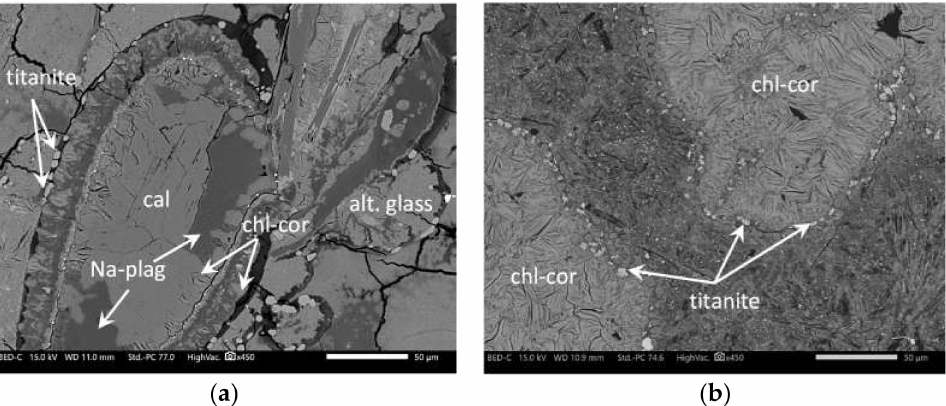
Figure 8. SEM petrographic observations in back-scattered electron mode. Chlorite (Chl), corrensite (Cor) ± Chl/Cor crystallizing inside vugs (filled by later calcite (cal) and Na plagioclase (Na-plag) ( a )). Alteration of glass is underlined by titanite crystals. Alt glass: altered glass ( a ): glassy basaltic dike at 556 m, ( b ): basaltic lava at 305.1 m.